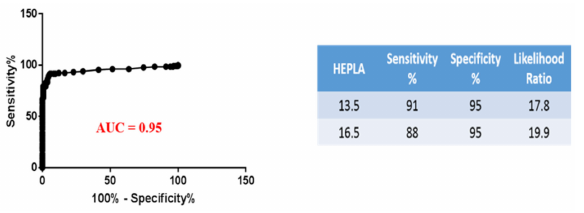
Figure 2. Diagnostic performance of FCA assessed by receiver operating characteristic (ROC) analysis of the HEPLA index ( n = 288), yielding an area under the curve of 0.95. The diagnosis of HIT was based on EOA as described in the “HIT diagnosis” section. FCA: Functional Cytometric assay, ROC: receiver operating characteristic, EOA: expert opinion